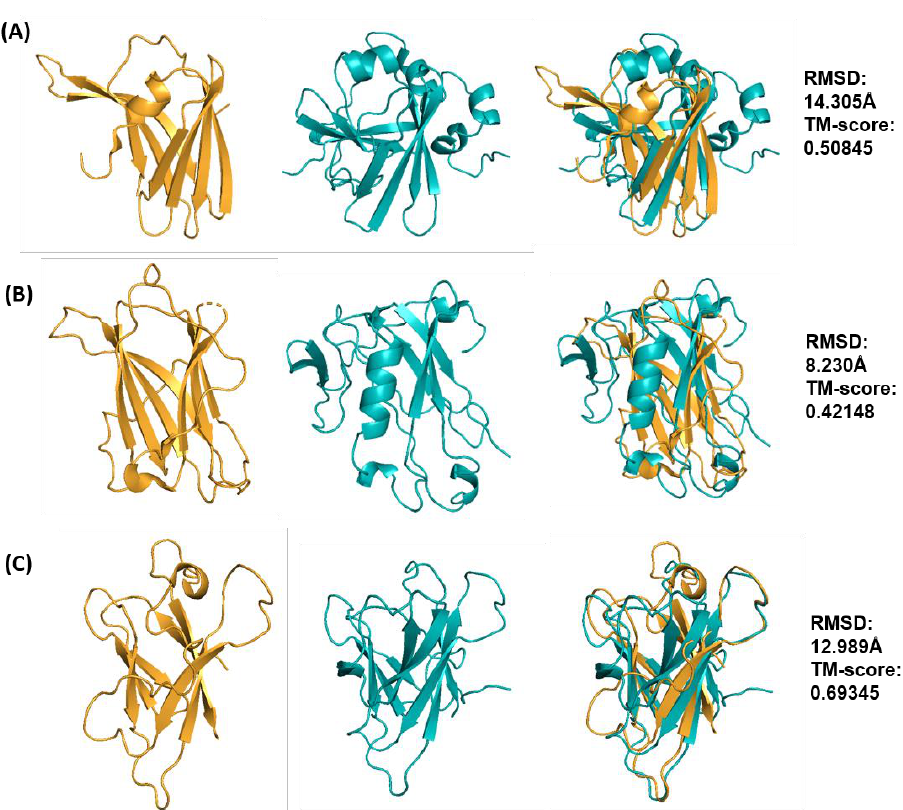
Figure 5. Best structural models for ToxA-like effector templates ToxA ( A ), Avr2 ( Fol ) ( B ), and AvrL567 ( C ) predicted with Rosetta ab initio modelling. All models are shown in cyan in ribbon representation and each model was superimposed onto their respective XRD or NMR template structure (shown in gold). RMSD and TM-score values are shown on the right-hand side.